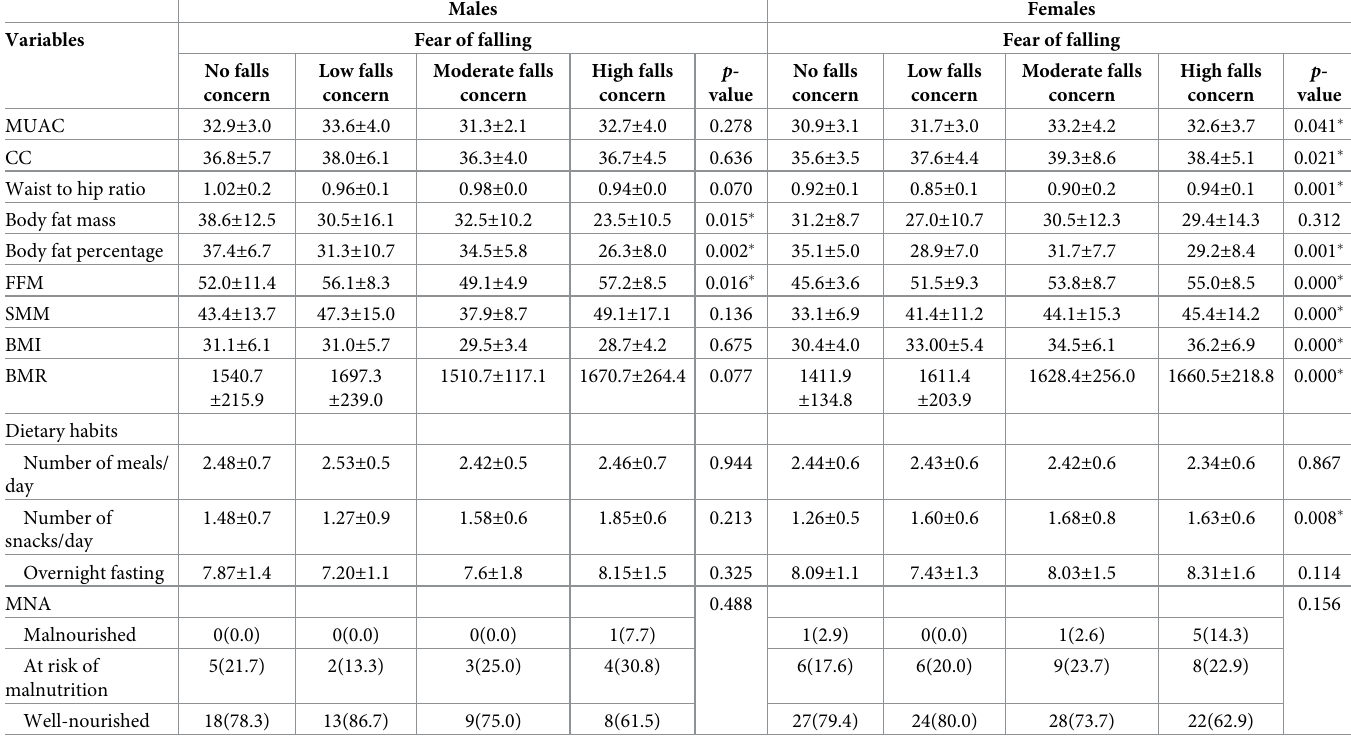
Table 4. Nutritional status according to fear of falling.